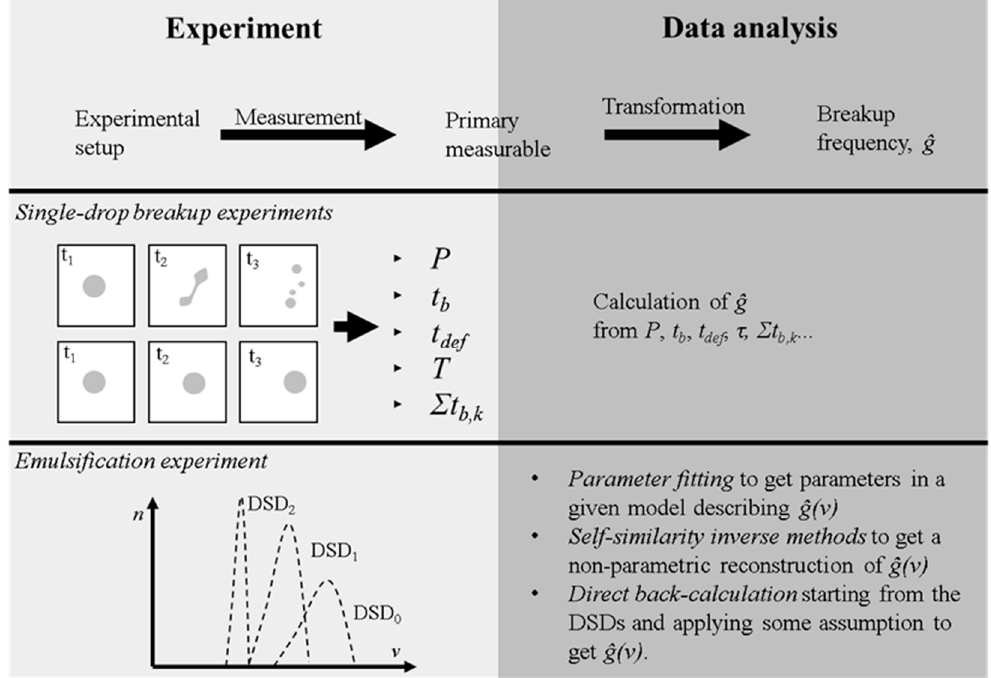
Figure 2. Schematic illustration of the two steps involved in measuring the breakup frequency (the experimental step and the data analysis step) and an illustration of the two principally different types of techniques employed to measure the breakup frequency: Single drop breakup experiment-based methods and emulsification experiment-based methods.